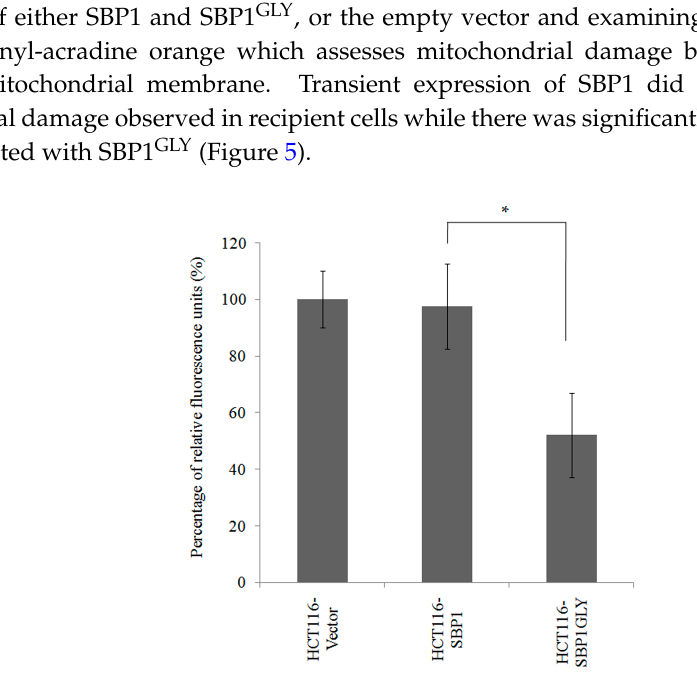
Figure 5. SBP1 GLY induced mitochondrial damage in HCT116 cells. Mitochondrial damage in HCT116